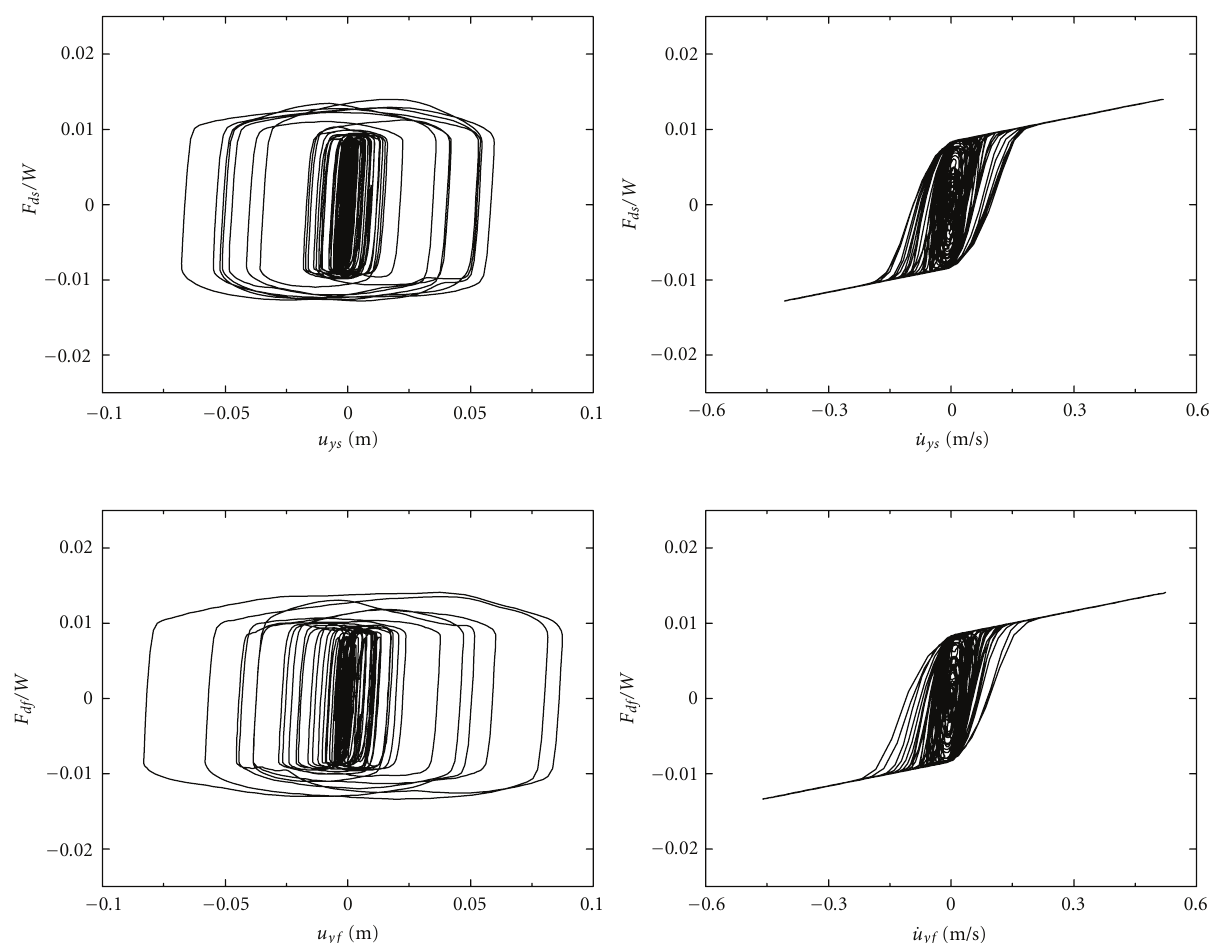
Figure 6: Normalized damper force-displacement and velocity loops for dampers located at sti ff and flexible edges for passive-o ff algorithm under Imperial Valley, 1940 earthquake ( T y = 1s, Ω θ = 1, e x / r = 0 . 3).